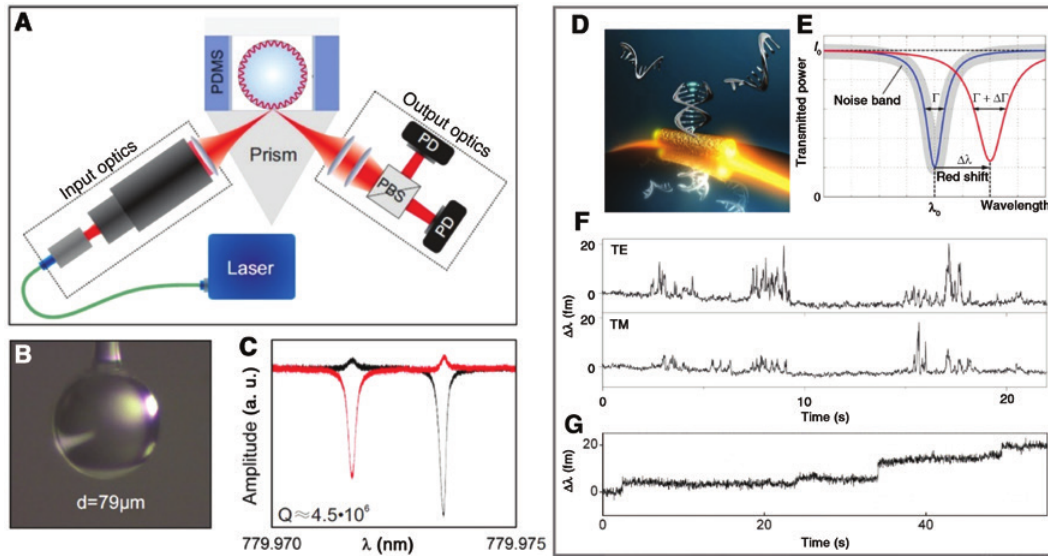
Figure 12: Detection of single DNA molecules and their interactions with optoplasmonic sensors. (A) A prism is used to couple light into the WGM of a glass microsphere for monitoring single molecules on a gold nanorod. (B) The glass microsphere is approximately 80 μ m in diameter and modified with a gold nanorod for highly sensitive detection. (C) WGM spectra acquired by swept-wavelength scanning of a tuneable laser source, operating at a wavelength of ~ 780 nm. (D) The nanorod attached to the micro- sphere sensor is modified with oligonucleotide receptors. (E) Binding of a DNA fragment from solution to an individual oligonucleotide receptor results in a resonant wavelength shift of the WGM. (F) The transient interactions between a DNA fragment and an oligonucleotide receptor appear as spikes in the wavelength shift signal, where each spike corresponds to a single-molecule interaction event. The interac- tion kinetics transition from the transient (F) to the permanent binding regime (G) dependent on the sequence of oligonucleotide receptors that is attached to the nanorod. Adapted from